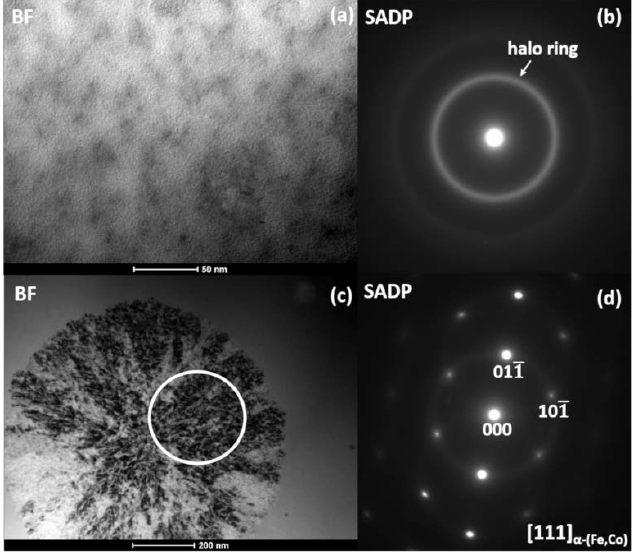
Figure 2. Bright-field (BF) images ( a , c ) and selected area di ff raction patterns (SADPs) ( b , d ) for as-spun Fe 67 Co 20 B 13 ribbon.